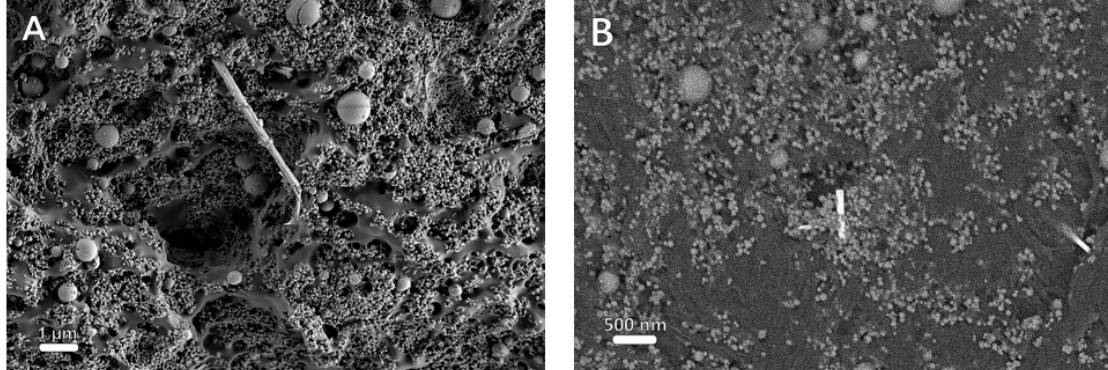
Figure 4. HR-SEM images of PLLA film reinforced with 40 wt% HA and 0.75 wt% INT-WS 2 film in SE mode ( A ), scale bar